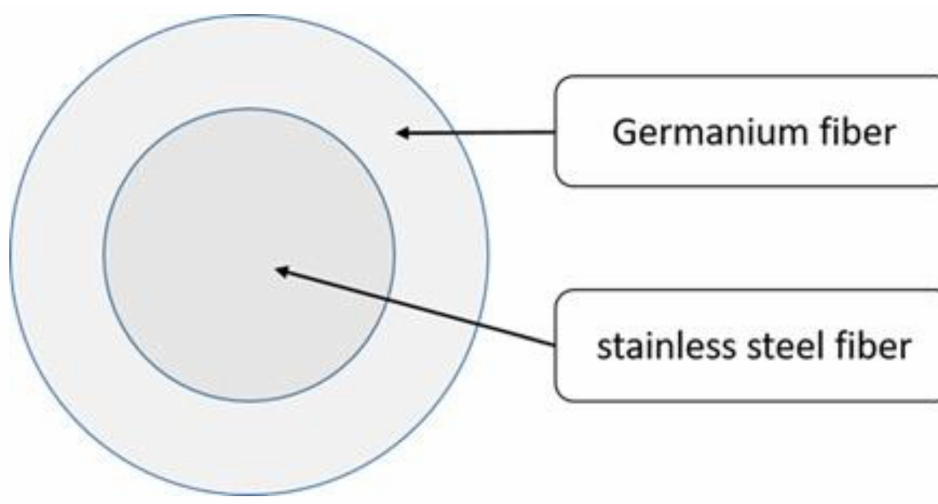
Figure 2. Diagram showing the composition of core-spun